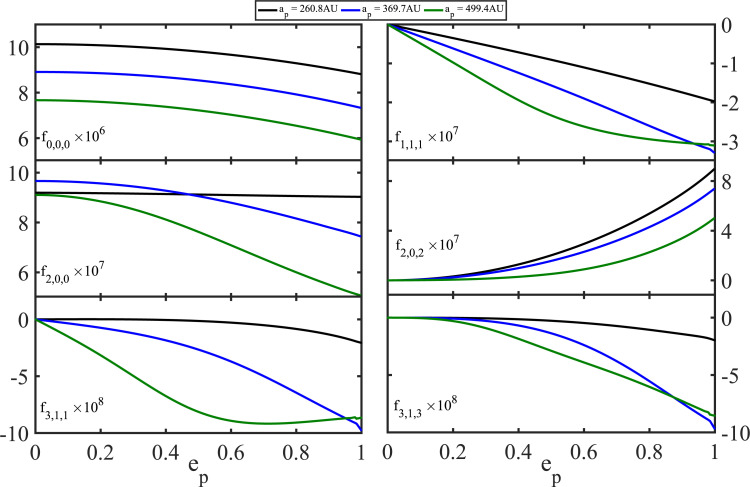
The behavior of numerically averaged functions
fl,m,n = <
al,m (r)
cos(nf)>
appearing in the disk potential (Equation
(39)) as a function of eccentricity ep for
orbits with different semimajor axes ap, as
shown. The calculation is performed for the fiducial disk configuration
DM1 (see Table 1). The chosen
values of ap correspond to semimajor axes at
which TNOs are observed (see Table
3). Note that the transition in behavior of fl,m,n with
varying semimajor axis is smooth.